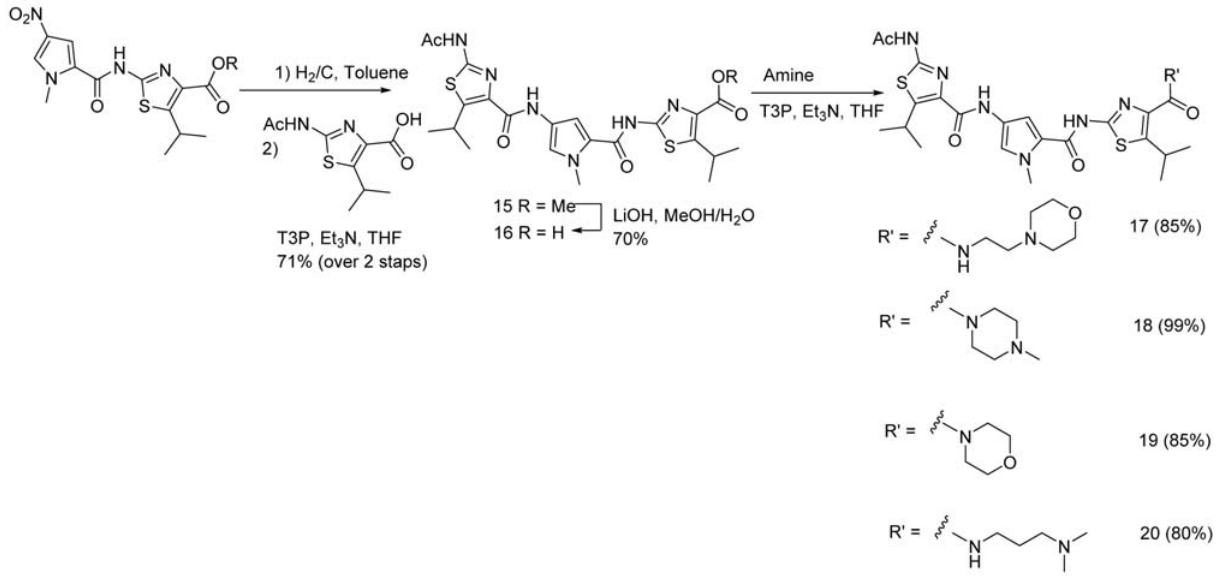
Scheme 5. Synthesis of heterocyclic oligoamide trimers